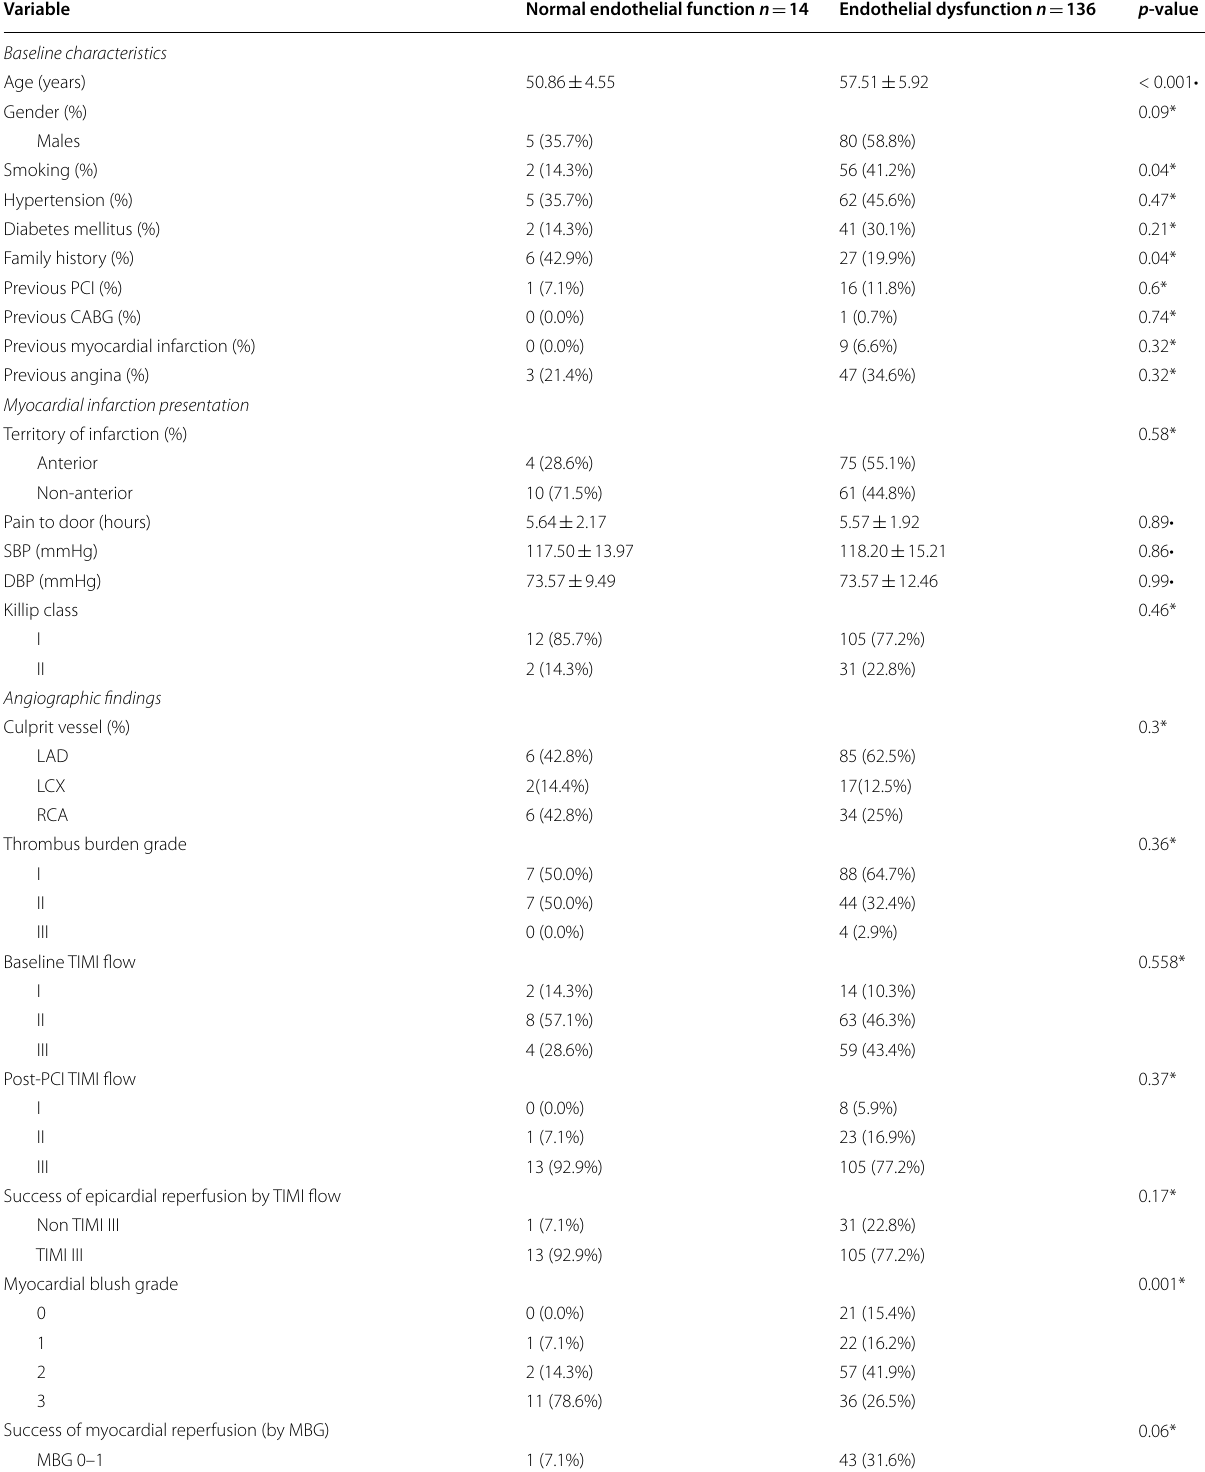
Table 2 Comparison between endothelial dysfunction and normal endothelial function groups Variable Normal endothelial function n